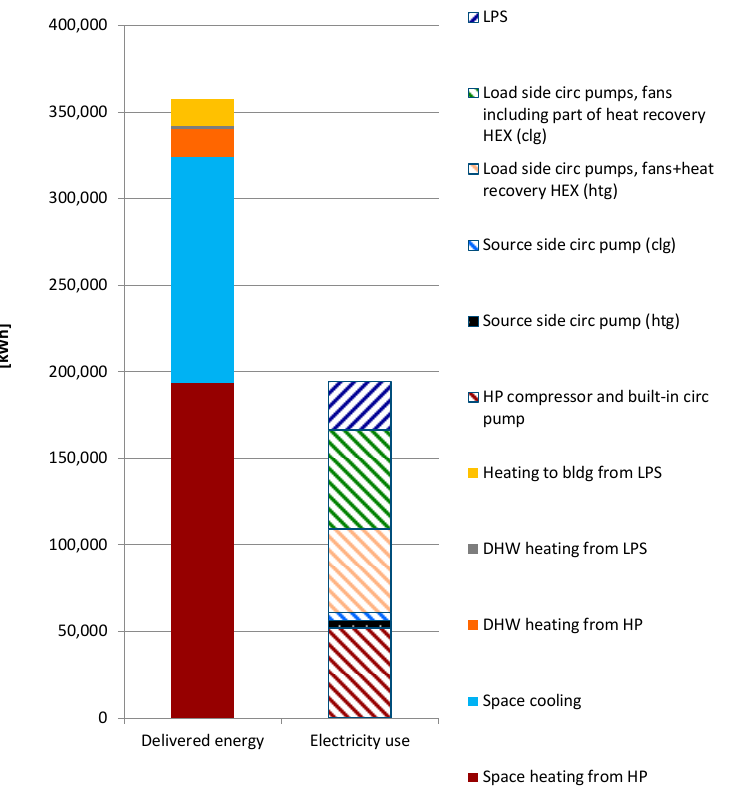
Figure 7. Annual delivered heating, cooling, and DHW provided ( left ), and electricity used ( right ). Note that delivered heating from exhaust air heat recovery is not included.